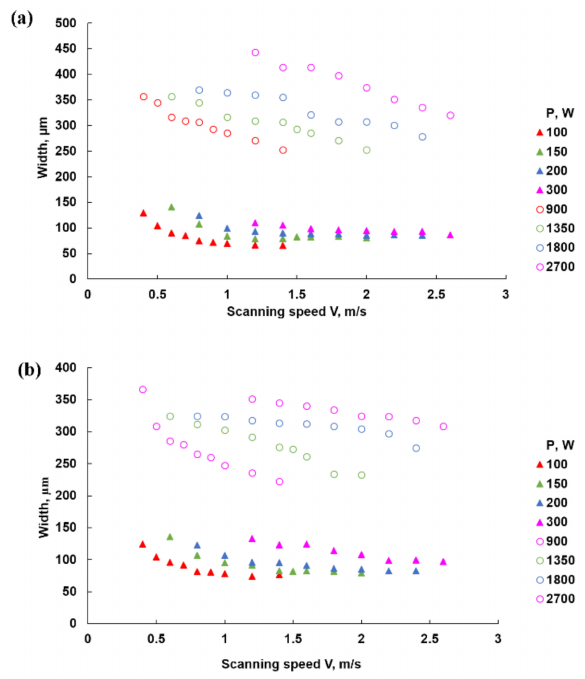
Figure 6. Width of the tracks at different laser powers and scanning speeds with powder ( a ) and without powder ( b